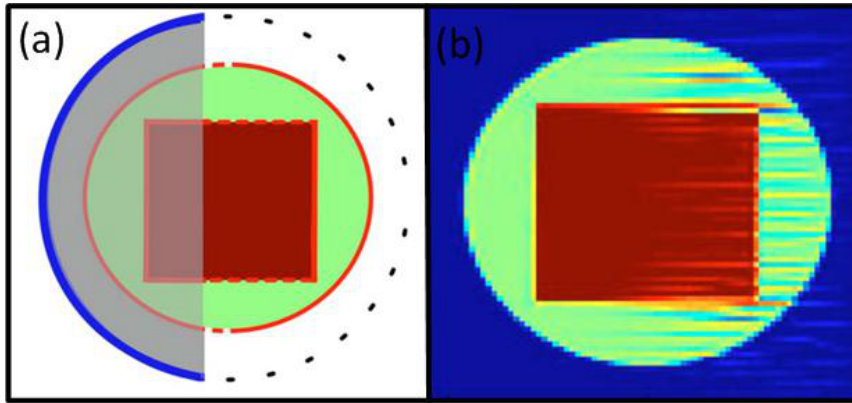
Figure 6. ( a ) Illustration of a limited view setup with detectors located on an open arc (solid blue line). Only the region covered by the detectors (shadowed area) can be reconstructed in a stable way. Sharp boundaries facing the detection surface (solid red lines) are visible whereas boundaries not facing the detection surface (dashed red lines) are invisible; ( b ) Reconstruction of ( a ) with a model-based inversion without regularization. Stripe artifacts arise due to the limited view geometry [116]. Reprinted with